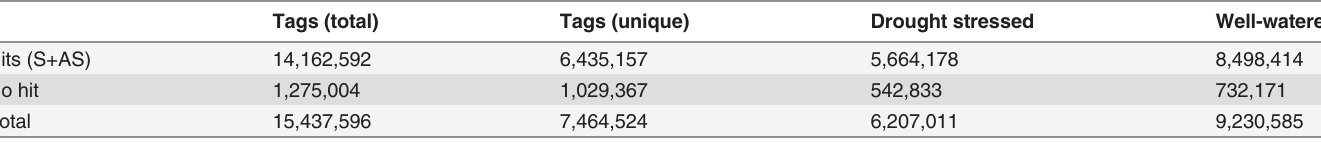
Table 1. Characteristics of the MACE libraries constructed from the drought stressed and the well-watered seedlings. Tags (total) Tags (unique) Drought stressed Well-watered Hits (S+AS) No hit Total Shown is the amount of total tags analyzed for the library, the amount of unique tags and the amount of tags for each treatment pool (drought stressed and